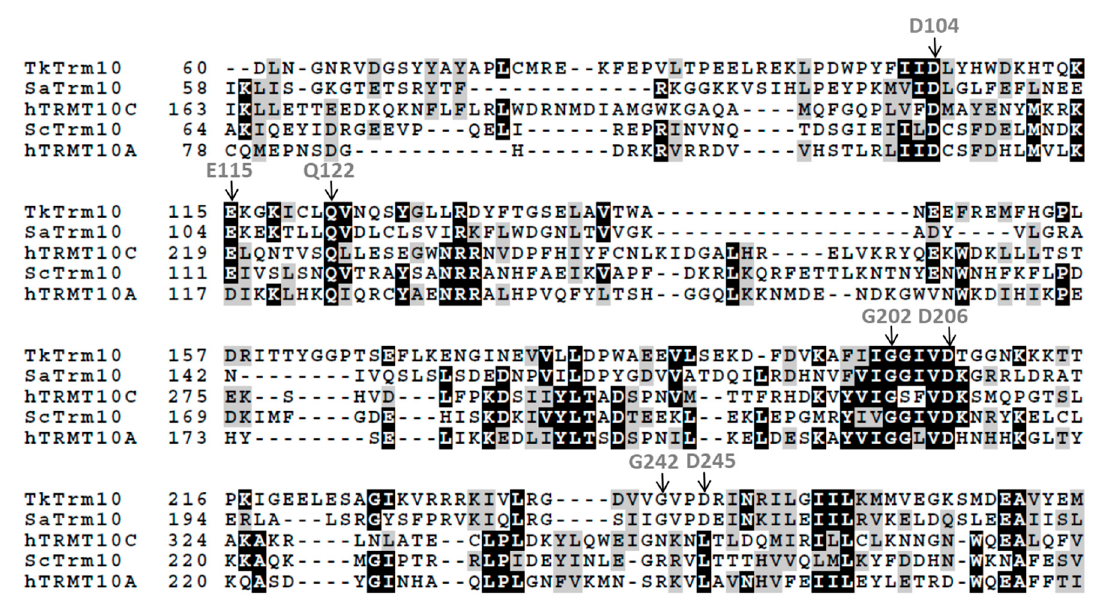
Figure 3. Multiple sequence alignment of Trm10 homologs: Alignment of eukaryotic (m 1 G 9 -specific ScTrm10 and hTRMT10A, m 1 R 9 -specific hTRMT10C) and archaeal (m 1 A 9 -specific